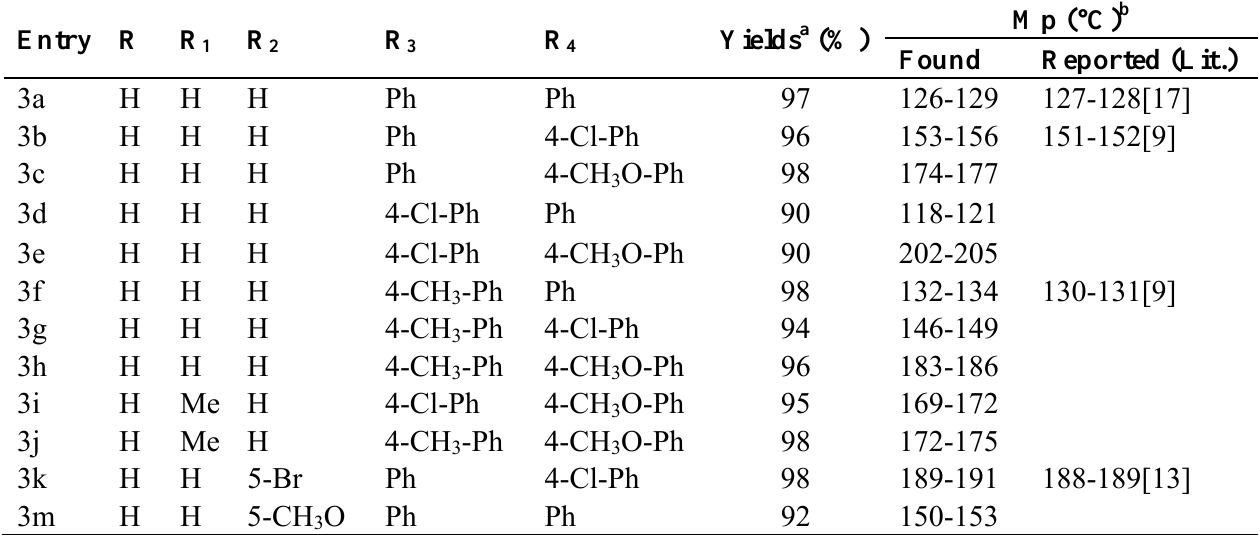
) SO H][ p -CH 2 4 3